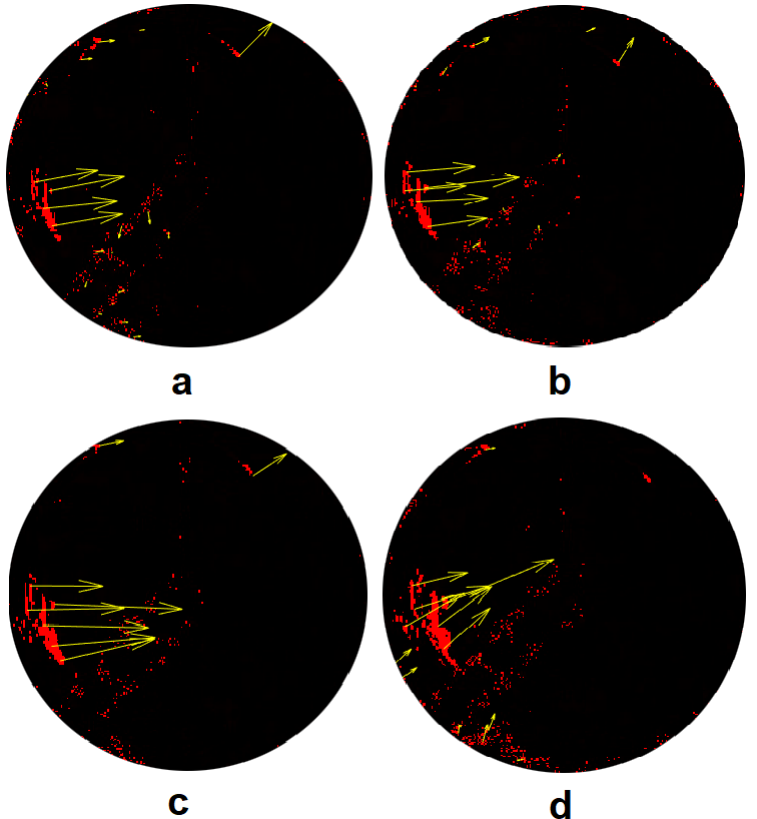
Figure 4. Displacement vectors of the cloud front. ( a ) corresponds to the time T = 0 min, ( b ) to T = 1 min, ( c ) to T = 2 min and ( d ) to T = 3